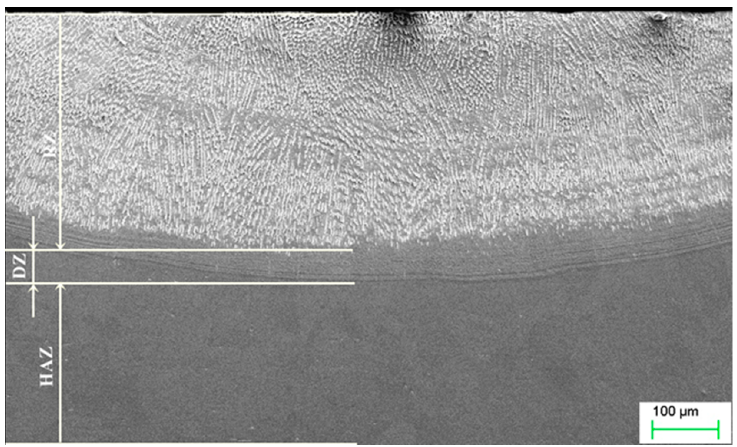
Figure 5. Microstructure of copper after Ti alloying. RZ = re melted zone, DZ = diffusion zone, HAZ = heat affected zone.